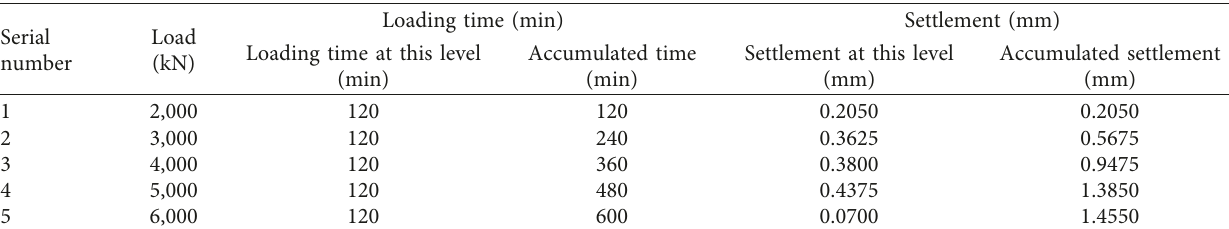
Figure 6: Loading device. (a) Anchor pile reaction device. (b) Eight hydraulic jacks. (c) The main beam and the secondary beam. (d) The displacement dial gauge. Table 3: Average settlement value of the test